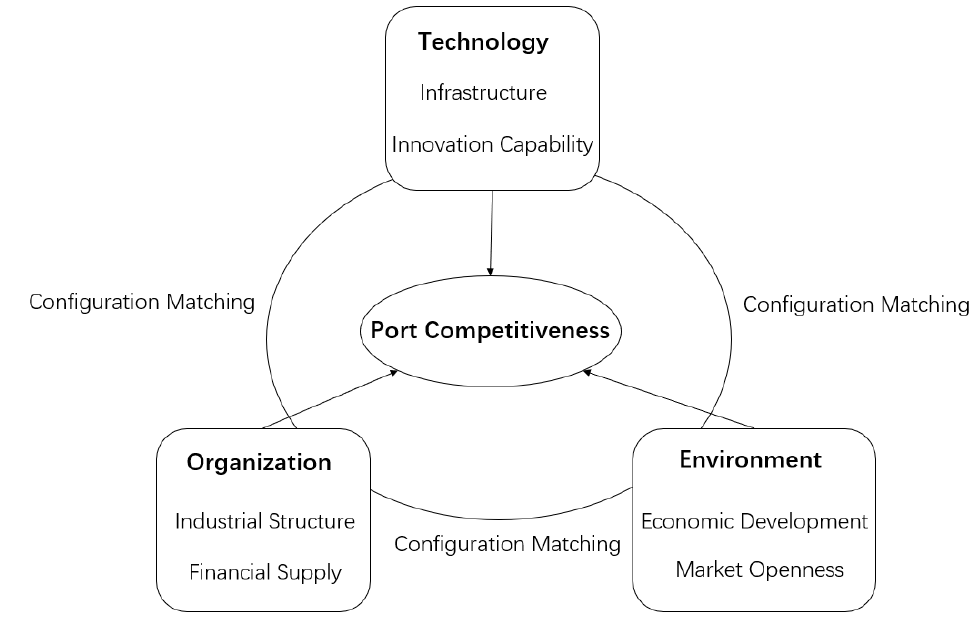
Figure 1. Configuration model based on TOE framework.